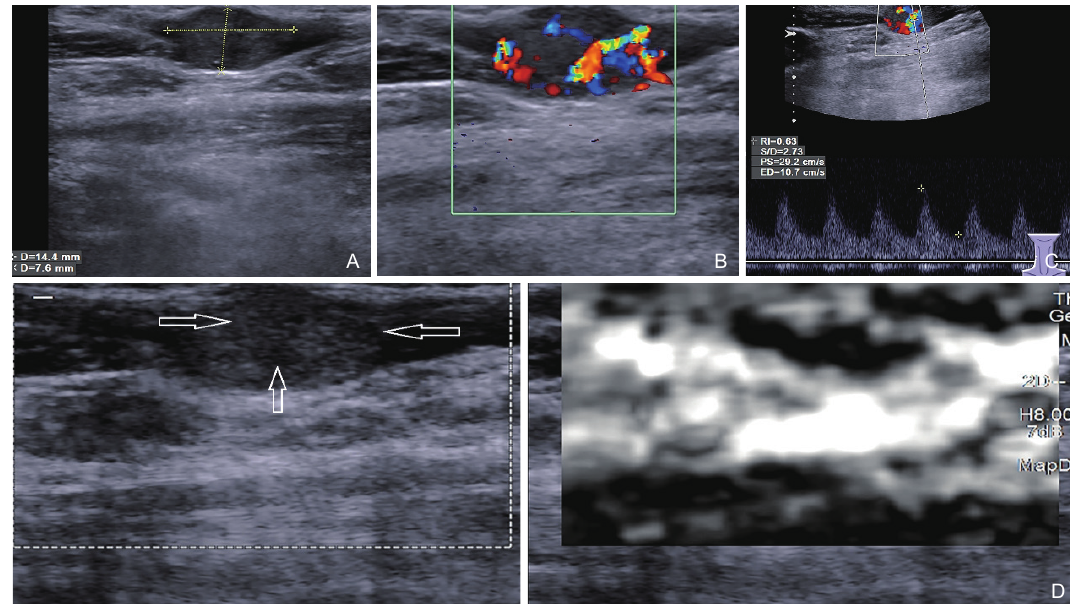
Figure 1 Intravenous lobular capillary haemangioma. Ultrasonographic findings. (A) Ultrasonographic findings for the hyperechoic mural nodule within the external jugular vein. (B) Color Doppler ultrasonography image of the nodule showing thick, strip-shaped and spot-like blood flow. (C) Pulsed Doppler ultrasonography revealing waveforms of arterial blood supply in the nodule. (D) EI showing that the nodule was mostly black, with a small white portion corresponding to the hypoechoic area on the two-dimensional image (hollow